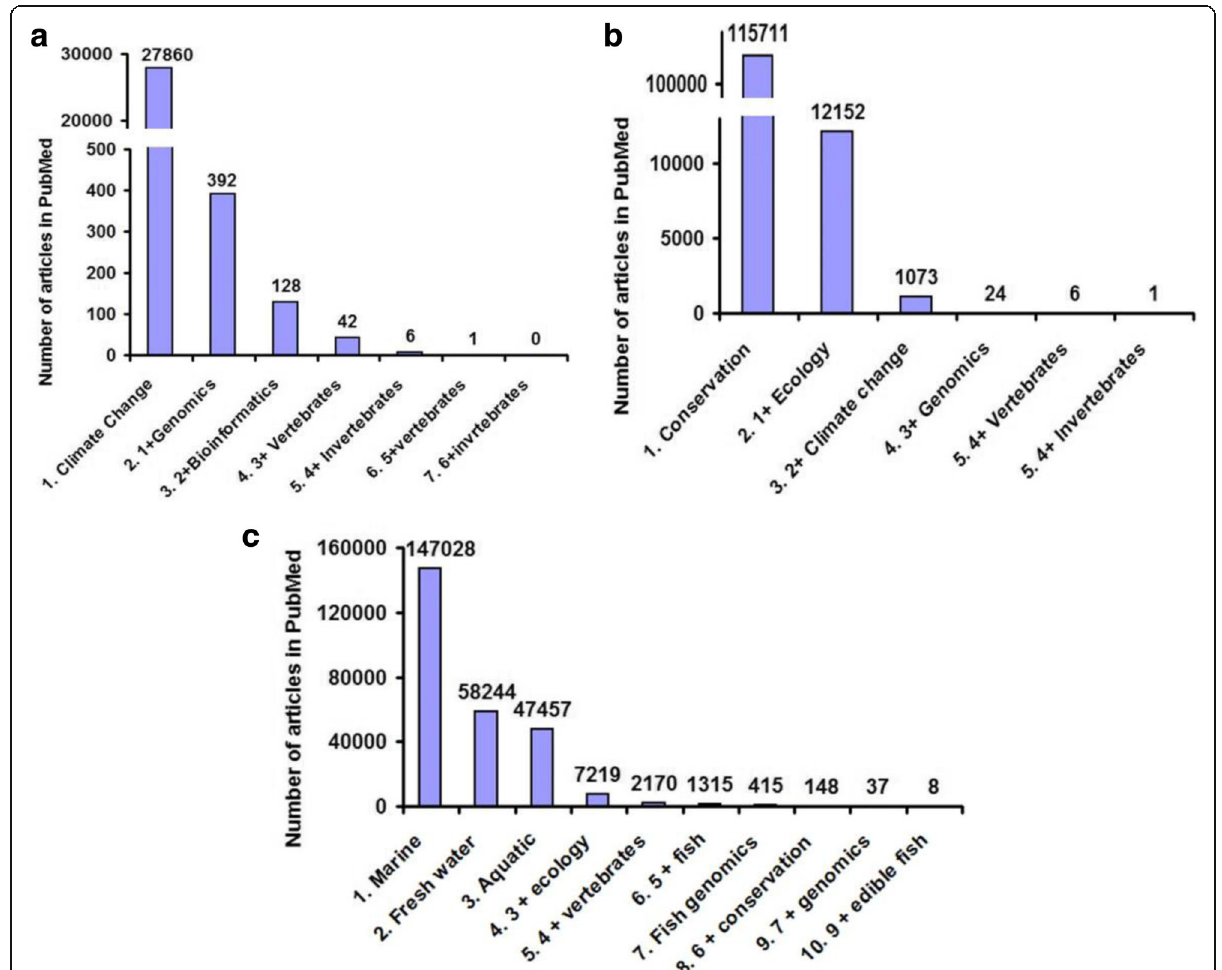
Fig. 1 Literature about ecogenomics in (edible) fish and invertebrates in relation to climate change in PubMed. a – c Figures show the search results with specific terms. Least work has been done on (edible) fish and aquatic invertebrates in relation to their